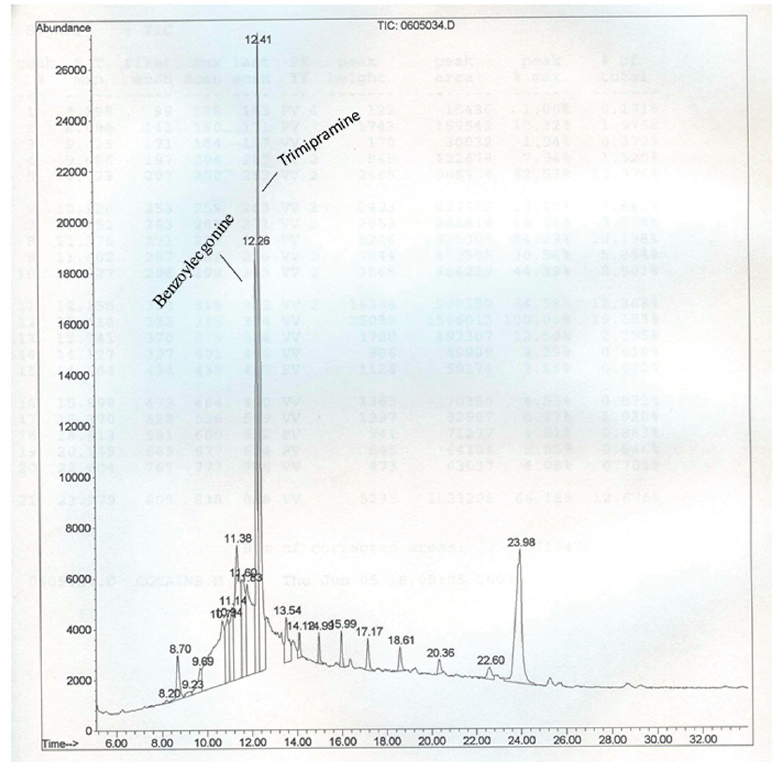
Figure 1. Chromatogram showing peaks of benzoylecgonine (metabolite standard for cocaine) and trimipramine (a tricyclic antidepressant used as internal standard). Since PAHs were detected during screening of autopsy samples for drug abuse, this chromatogram is shown to present the retention time for the cocaine